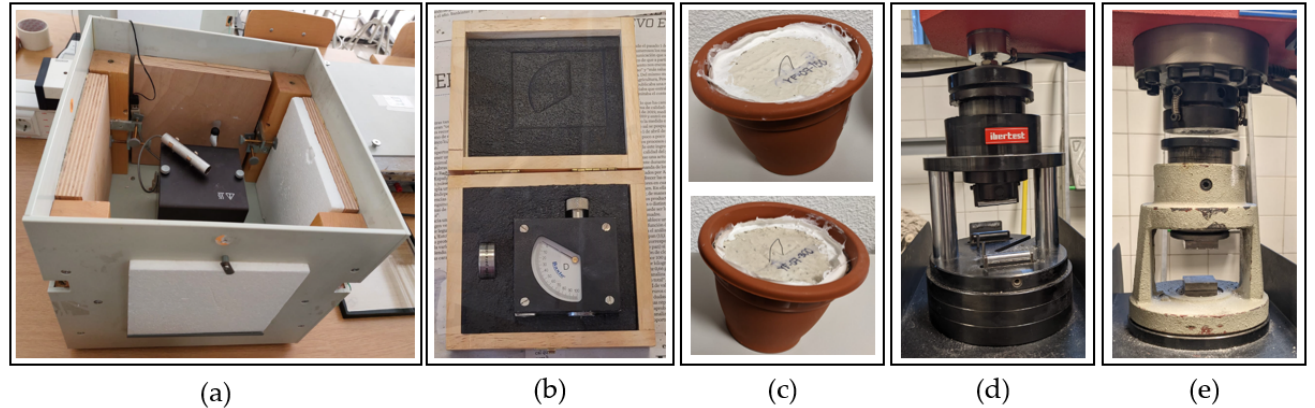
Figure 5. ( a ) Thermal box; ( b ) Shore C hardness tester; ( c ) water vapour permeability test; ( d ) and ( e ) hydraulic press, flexural and compression test modules.